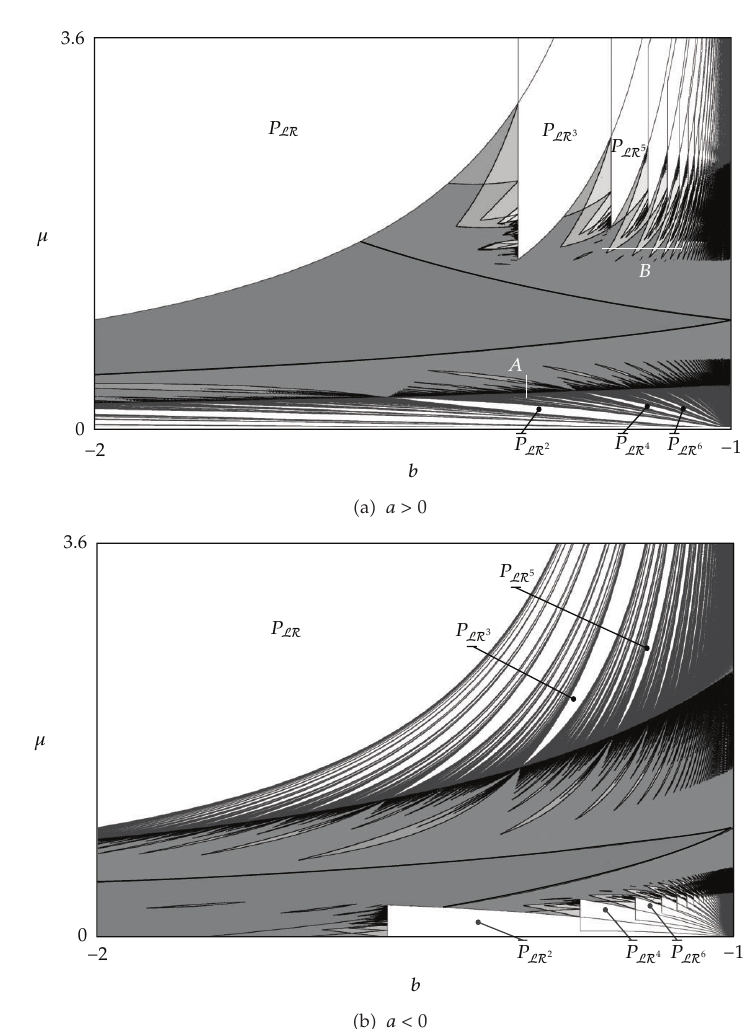
Figure 4: Numerically calculated bandcount diagrams in the 2D parameter space for a (cid:6) 0 . 42 (cid:7) a (cid:8) , a (cid:6) − 0 . 42 (cid:7) b (cid:8) and b (cid:6) − 2 . 0 ··· − 1 . 0, μ (cid:6) 0 ··· 3 . 6, showing the basic bifurcation structure of the chaotic domain. The periodic domain is colored white, the chaotic domain in various shades of gray. The gray tones represent the bandcount of the regions, calculated using the numeric approach reported in (cid:2) 48 (cid:3) . The lighter the gray of a chaotic region the higher its bandcount is. The white lines in (cid:7) a (cid:8) show the locations of two bifurcation scenarios, shown in Figures 9 and